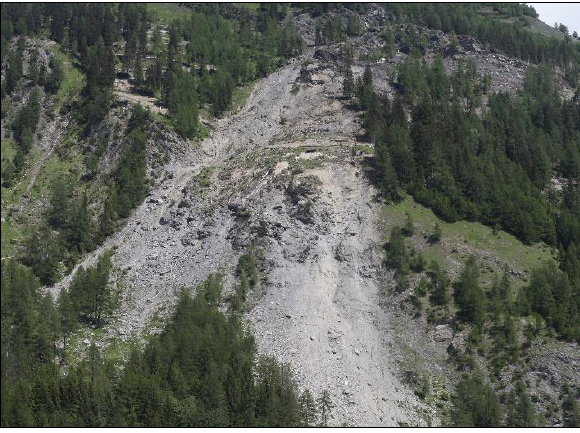
Figure 1: The Mont de la Saxe landslide (25 June 2013) The landslide is monitored since 2009; a slow continuous movement alternates with sudden accelerations. This complex dynamics drew international attention not only to assess the geological and geotechnical problems, but also to evaluate